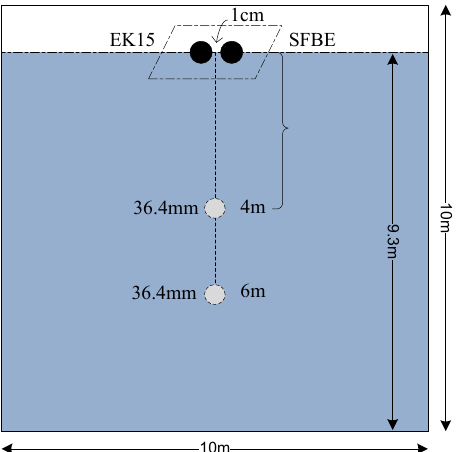
Figure 14. Experimental setup for the first experiment. The 36.4 mm sphere was placed at 4 m at first and then lower to 6